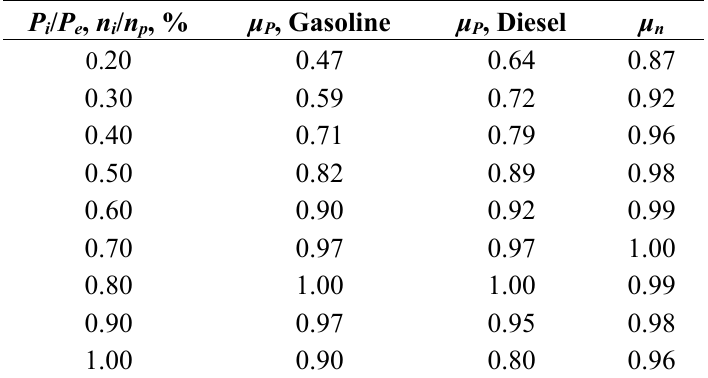
Table 1. Coefficient